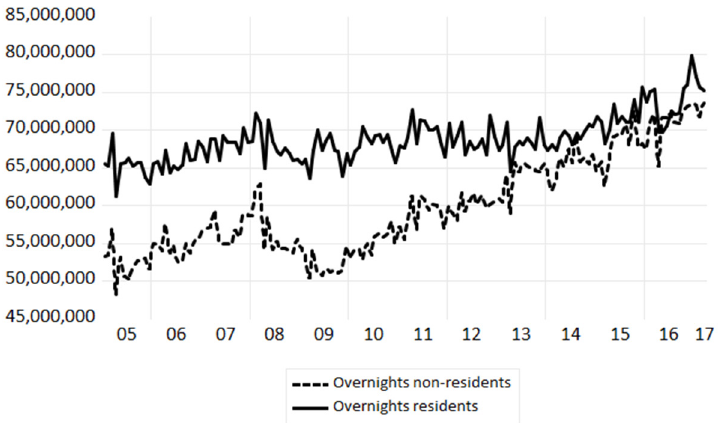
Figure 2. Overnights of residents (solid line) and non-residents (dashed line) for the EU-27 (seasonally adjusted by the multiplicative ratio to moving average method). Source: Eurostat and illustration.